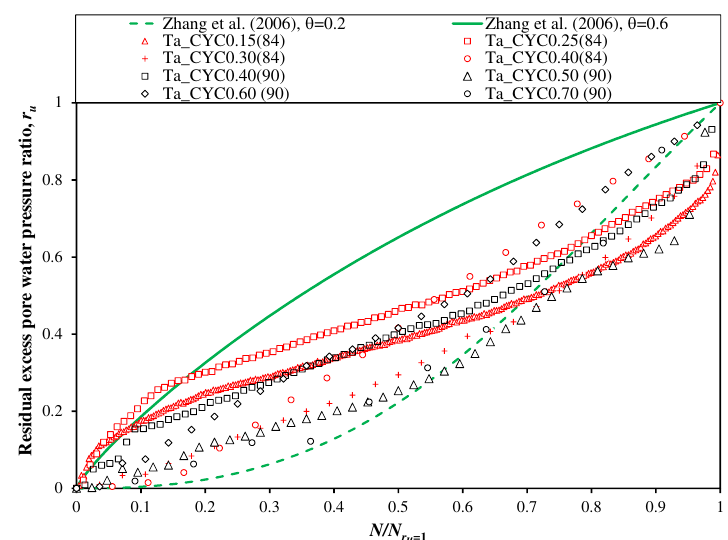
Fig. 6 Relationship between excess PWP ratio ( r u ) and the normalised number of cycles ( N ) by the number of cycles at